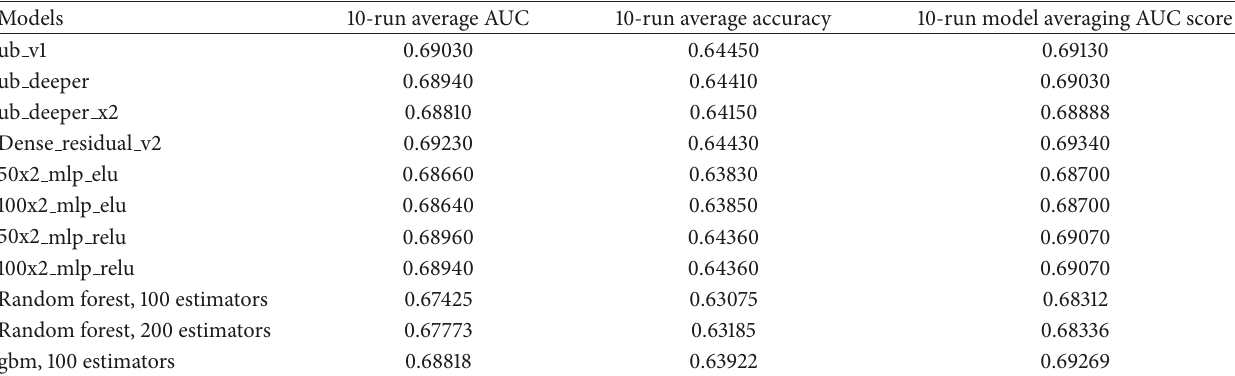
Table 4: Classifier performance on dataset 2.